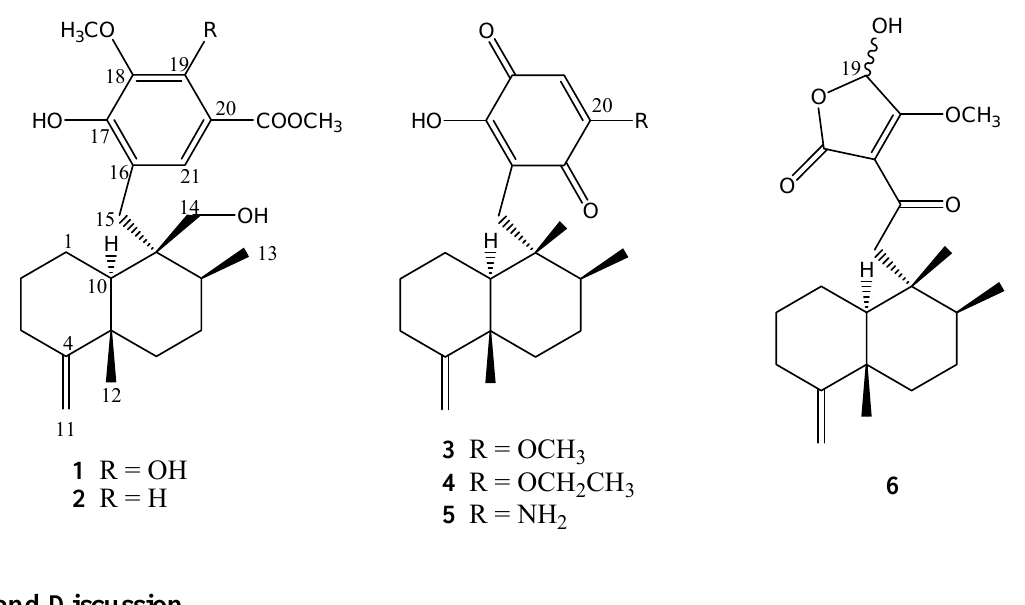
Figure 1. The structures of compounds 1-6